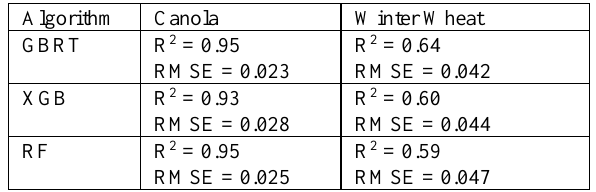
Table 3. Results of soil moisture retrieval over canola and winter wheat agricultural region using GBRT, XGB, and RF algorithms